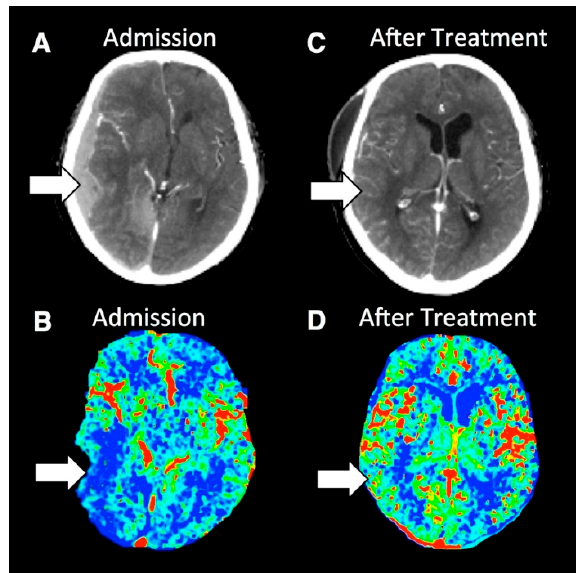
Figure 6. Contrast-enhanced and PCT images from a patient with severe TBI. ( A ) Contrast-enhanced